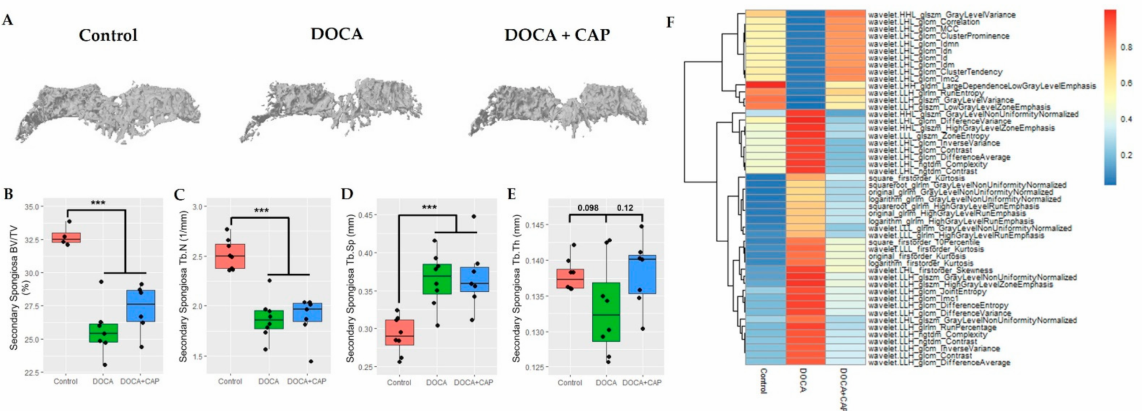
Figure 3. ( A ) The 3D bone structure of secondary spongiosa under micro-CT with the ( B ) bone volume ratio (BV/TV), ( C ) trabecular number (Tb.N), ( D ) trabecular separation (Tb.Sp), and ( E ) trabecular thickness (Tb.Th) calculated for the Control, DOCA, and DOCA+Captopril groups, respectively. (*** p < 0.001) ( F ) The heatmap of the mean values of the top 50 radiomic features quantifying the texture of secondary